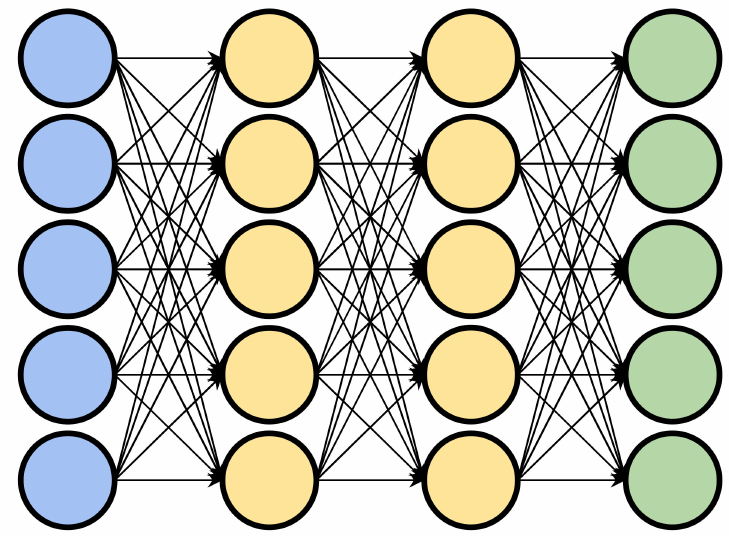
Figure 3. A representation of a deep learning neural network. Input layer in blue, output layer in green, and intermediate layers in